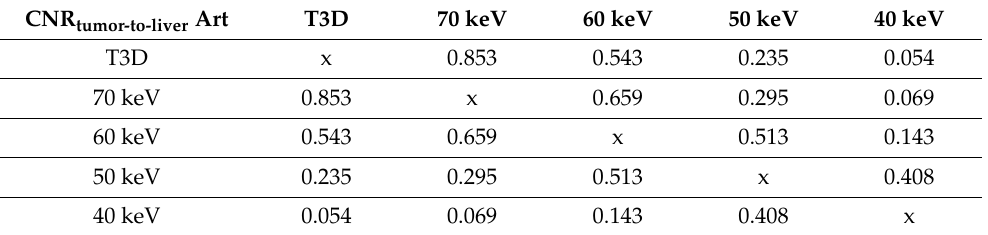
Table 11. Comparison of arterial CNR tumor-to-liver between T3D and low keV images. CNR tumor-to-liver Art T3D 70 keV